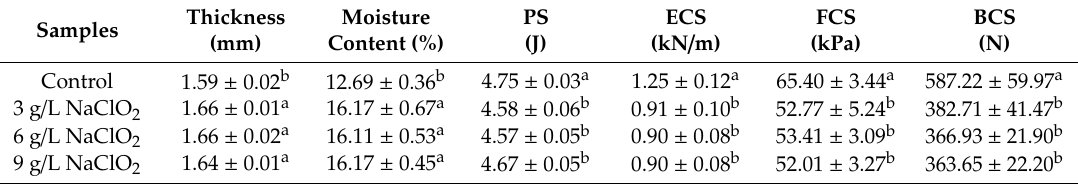
Table 1. Thickness, moisture content and strength index of corrugated cardboard and